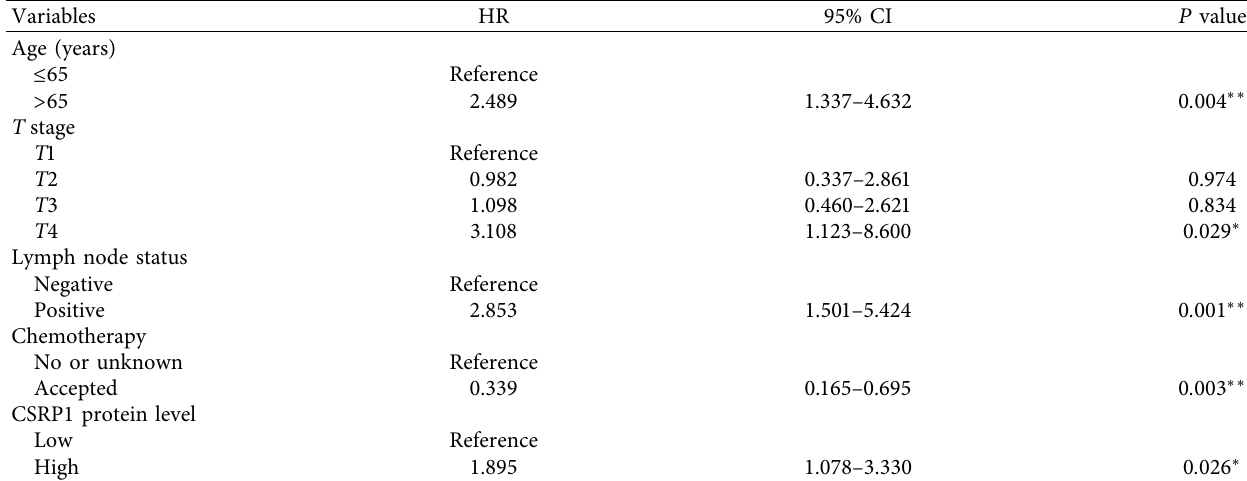
Figure 3: Survival analyses of COAD cohort from our hospital. Te overall survival curve of entire COAD cohort was plotted using Kaplan–Meier method (a) In addition, survival curves were compared in diferent sub-groups divided based on patients’ age (b), sex (c), tumor location (d), tumor size (e), T stage (f), lymph node metastasis (g), chemotherapy (h), and CSRP1 protein level (i) Table 3: Multivariate analysis for overall survival of enrolled COAD